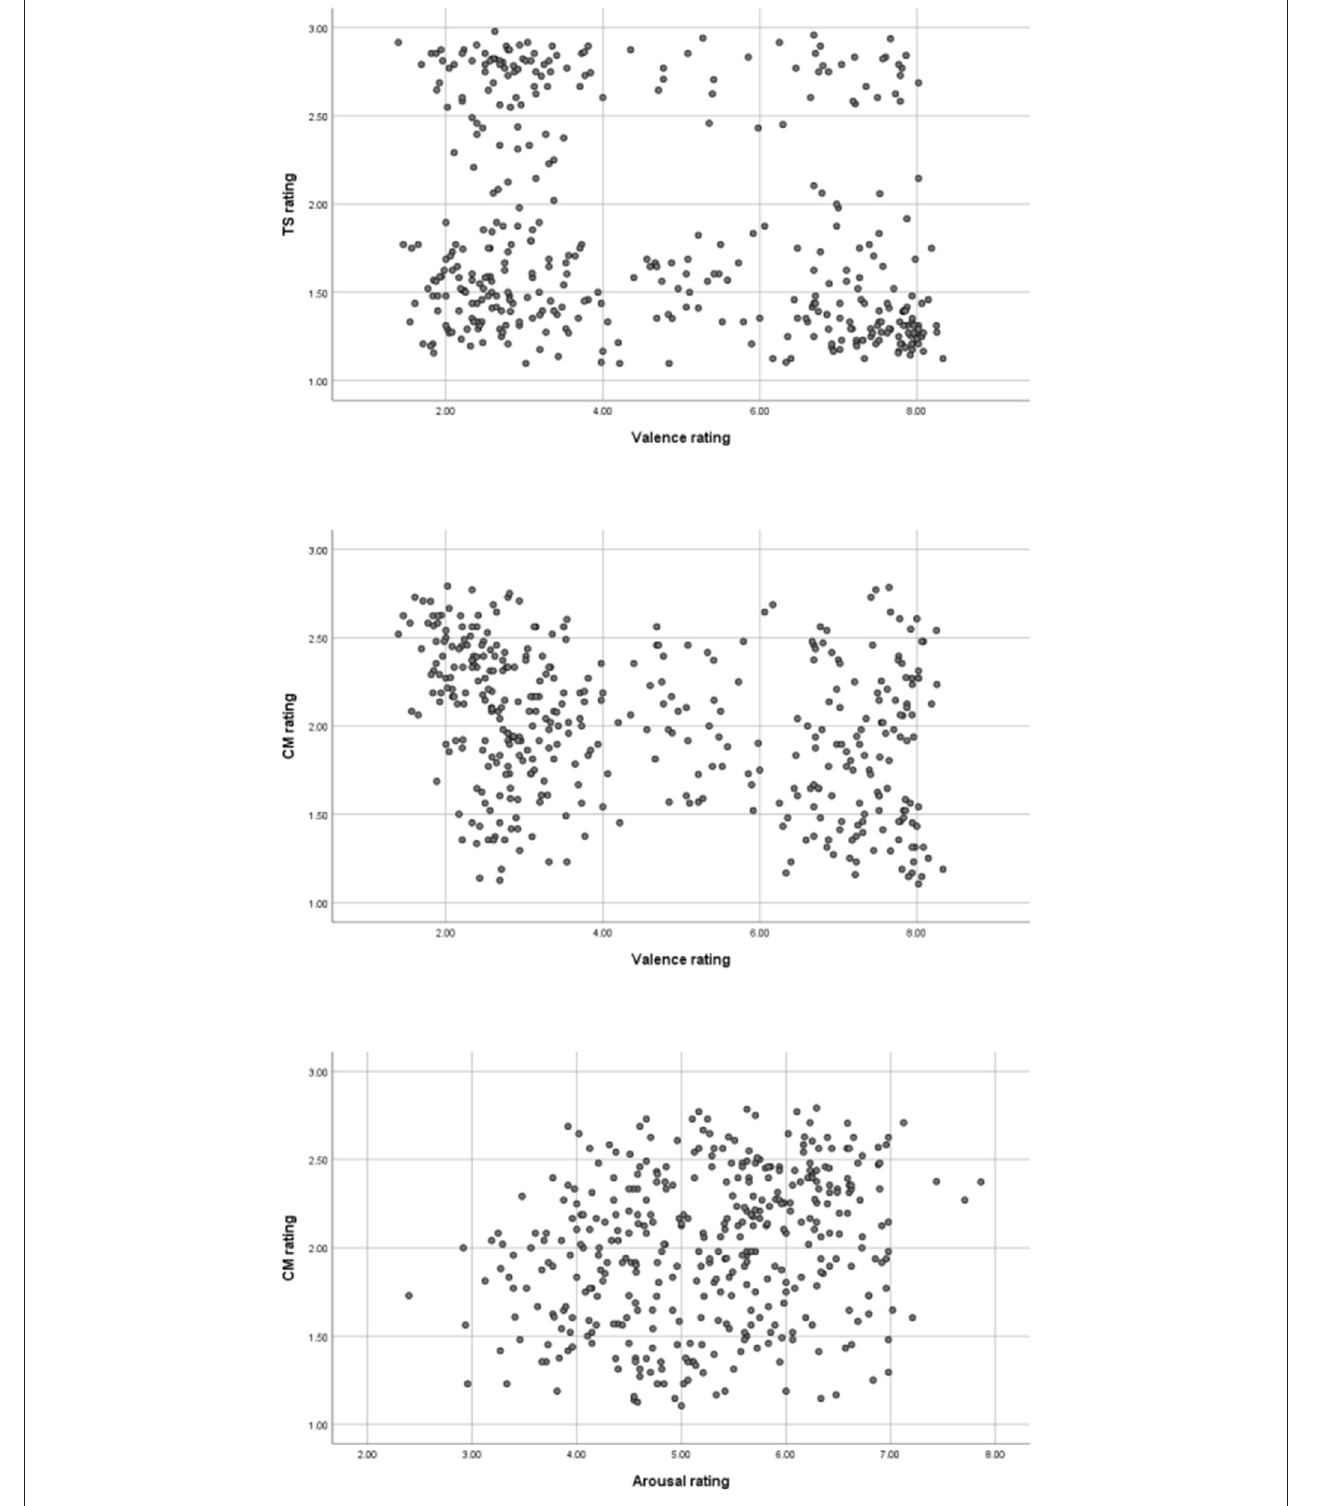
FIGURE 3 | Scatterplots of the significant correlations between affective (valence and arousal), category (TS, trait-state), and social judgment (CM, competence-morality) dimension ratings.